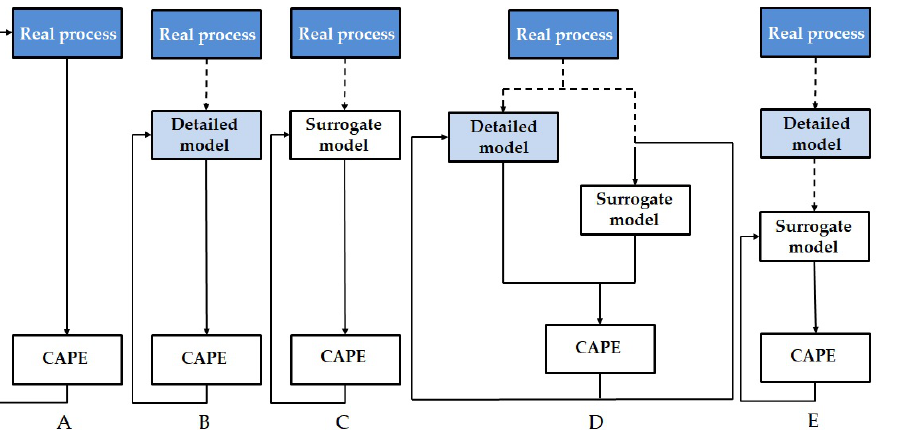
Figure 4. Surrogate-based Computer-Aided Process Engineering (CAPE) activities [59] (A: approach without model, B: approach with detailed model, C: approach with surrogate model, D: multi-fidelity approach, E: surrogate model is used to accelerate the detailed